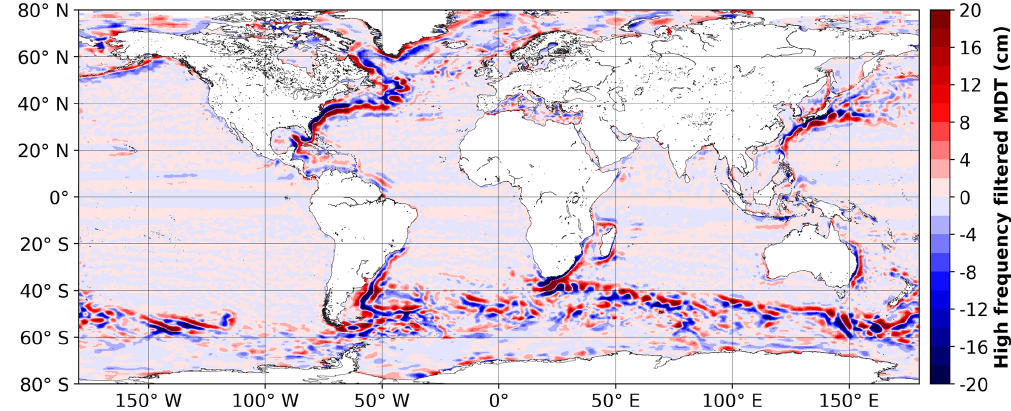
Figure 7. High frequency of the mean dynamic topography (MDT) filtered with a 700km half-power cutoff